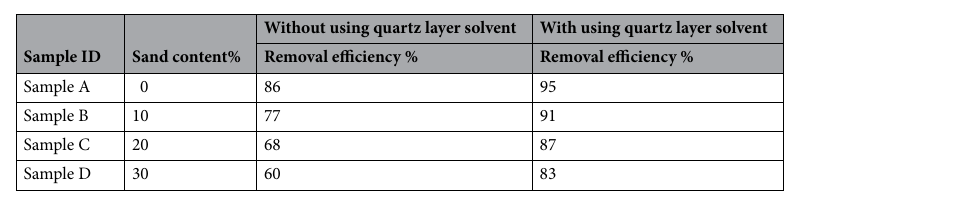
Table 2. Removal efficiency of barite filter cake with and without the HF